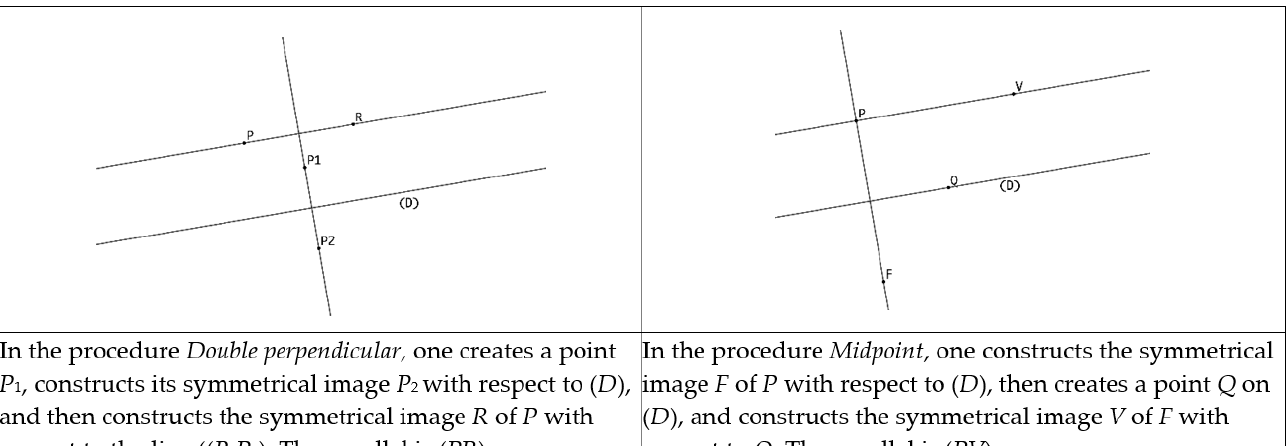
Figure 1. The two predominant correct procedures in the parallel construction task. Over the following decades, the research and development activities carried out at the IMAG around Cabri-g é om è tre and then Cabri II, Cabri II Plus, and Cabri 3D have continued to be based on this vision of DGE as a medium for creating adidactic milieus and on the design